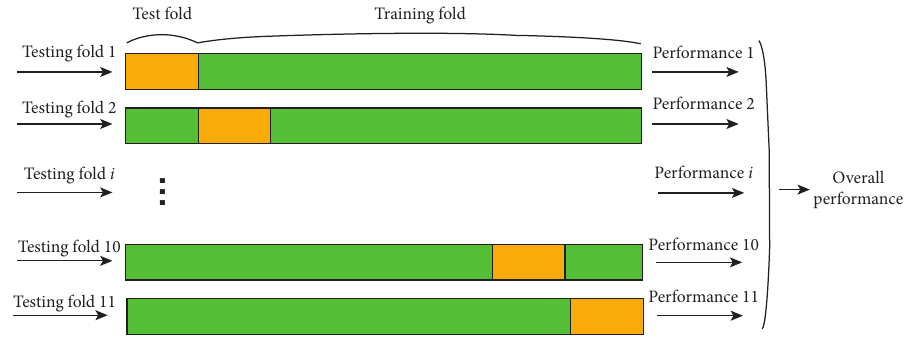
Figure 3: Diagram of 11-fold